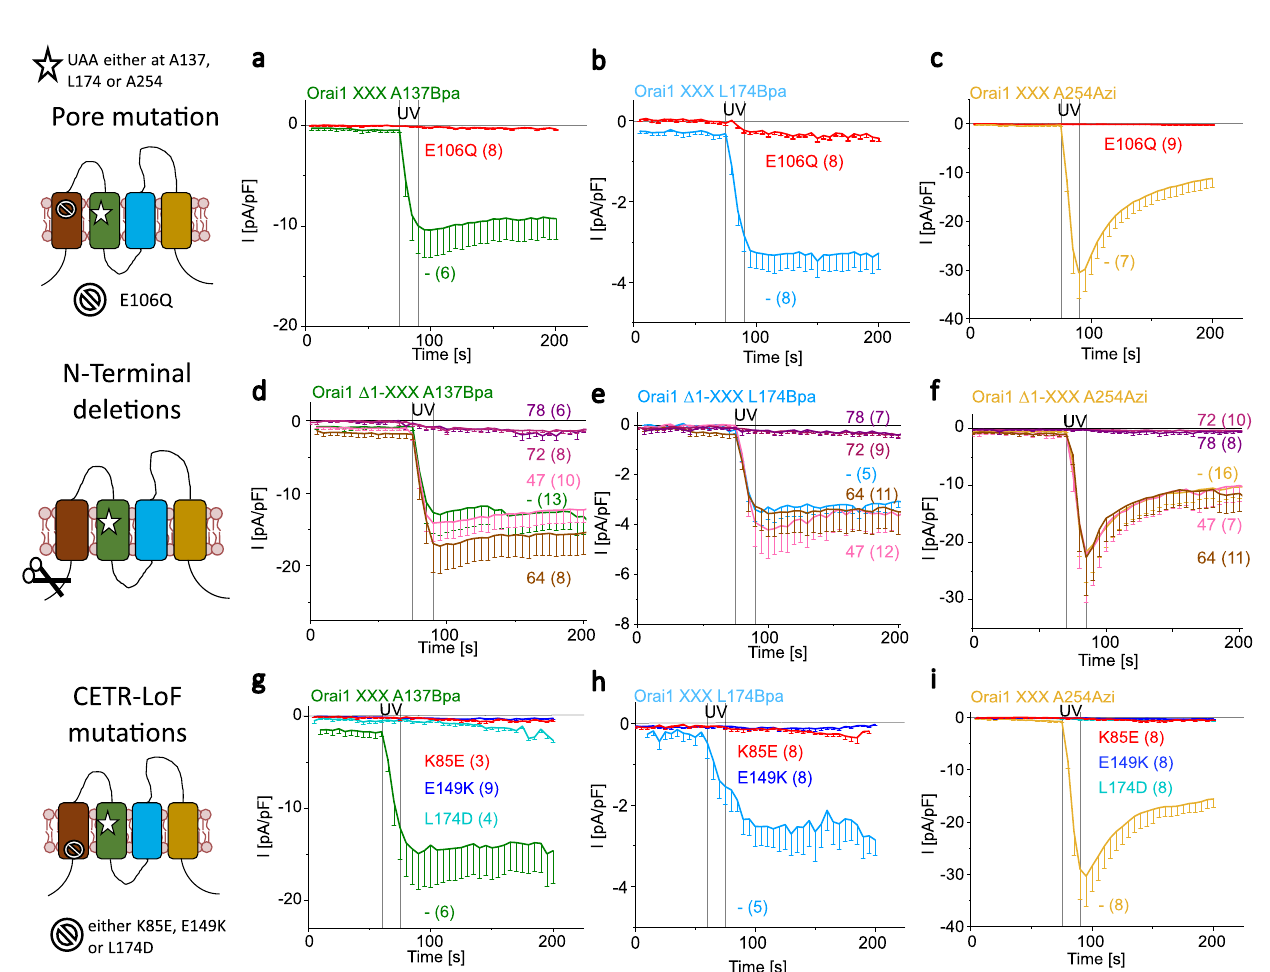
Fig. 6 | GoF mutations in Orai1 TM domains, but not Orai1 nexus mutation, interfere with UV-mediated activation of photocrosslinking UAA-containing Orai1 mutants. Graphical illustration on the left-hand side represents photo- crosslinking UAA-containing Orai1 mutants, exemplarily shown for Orai1 A137Bpa (star), combined with one of the following GoF mutations: V102A, H134A, V181K, P245L and 261 ANSGA 265 (black line). a Bar diagram summarizes currents measured beforeandafterapplicationofUVlightfortheabovementionedphotocrosslinking UAA- and GoF-containing Orai1 double mutants (Welch-ANOVA for Orai1 A137Bpa mutants: F(11;21,41)=7, p =7.5*10 − 5 ; for Orai1 L174Bpa mutants F(11;27,79)=16,48, p =1.96*10 − 9 ; for Orai1 A254Azi mutants F(11;32,59)=15,15, p =6.72*10 − 10 ). b Bar